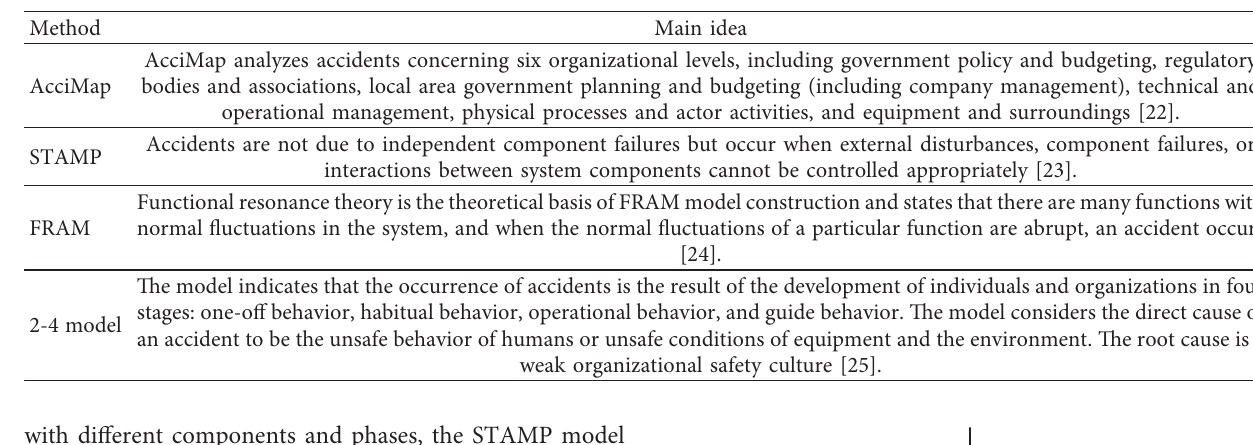
Table 1: System thinking method.